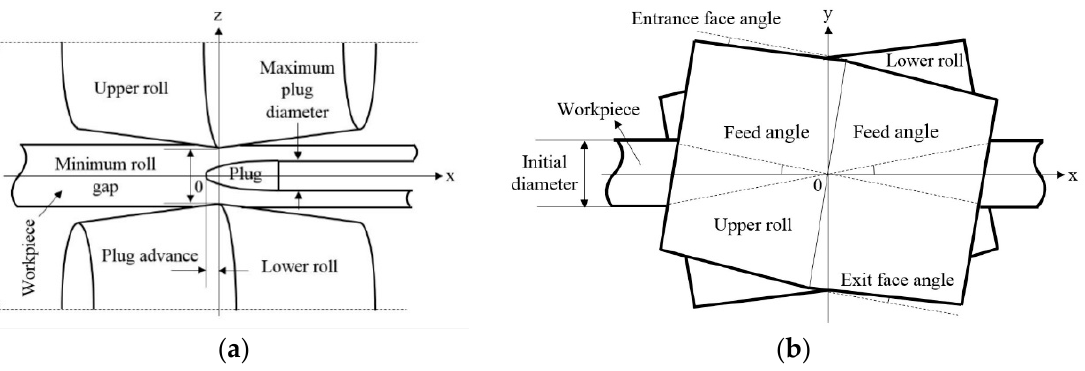
Figure 21. Schematic diagram of the rotary piercing process: ( a ) front view; ( b ) top view [24] (Reprinted from ref. [24]).